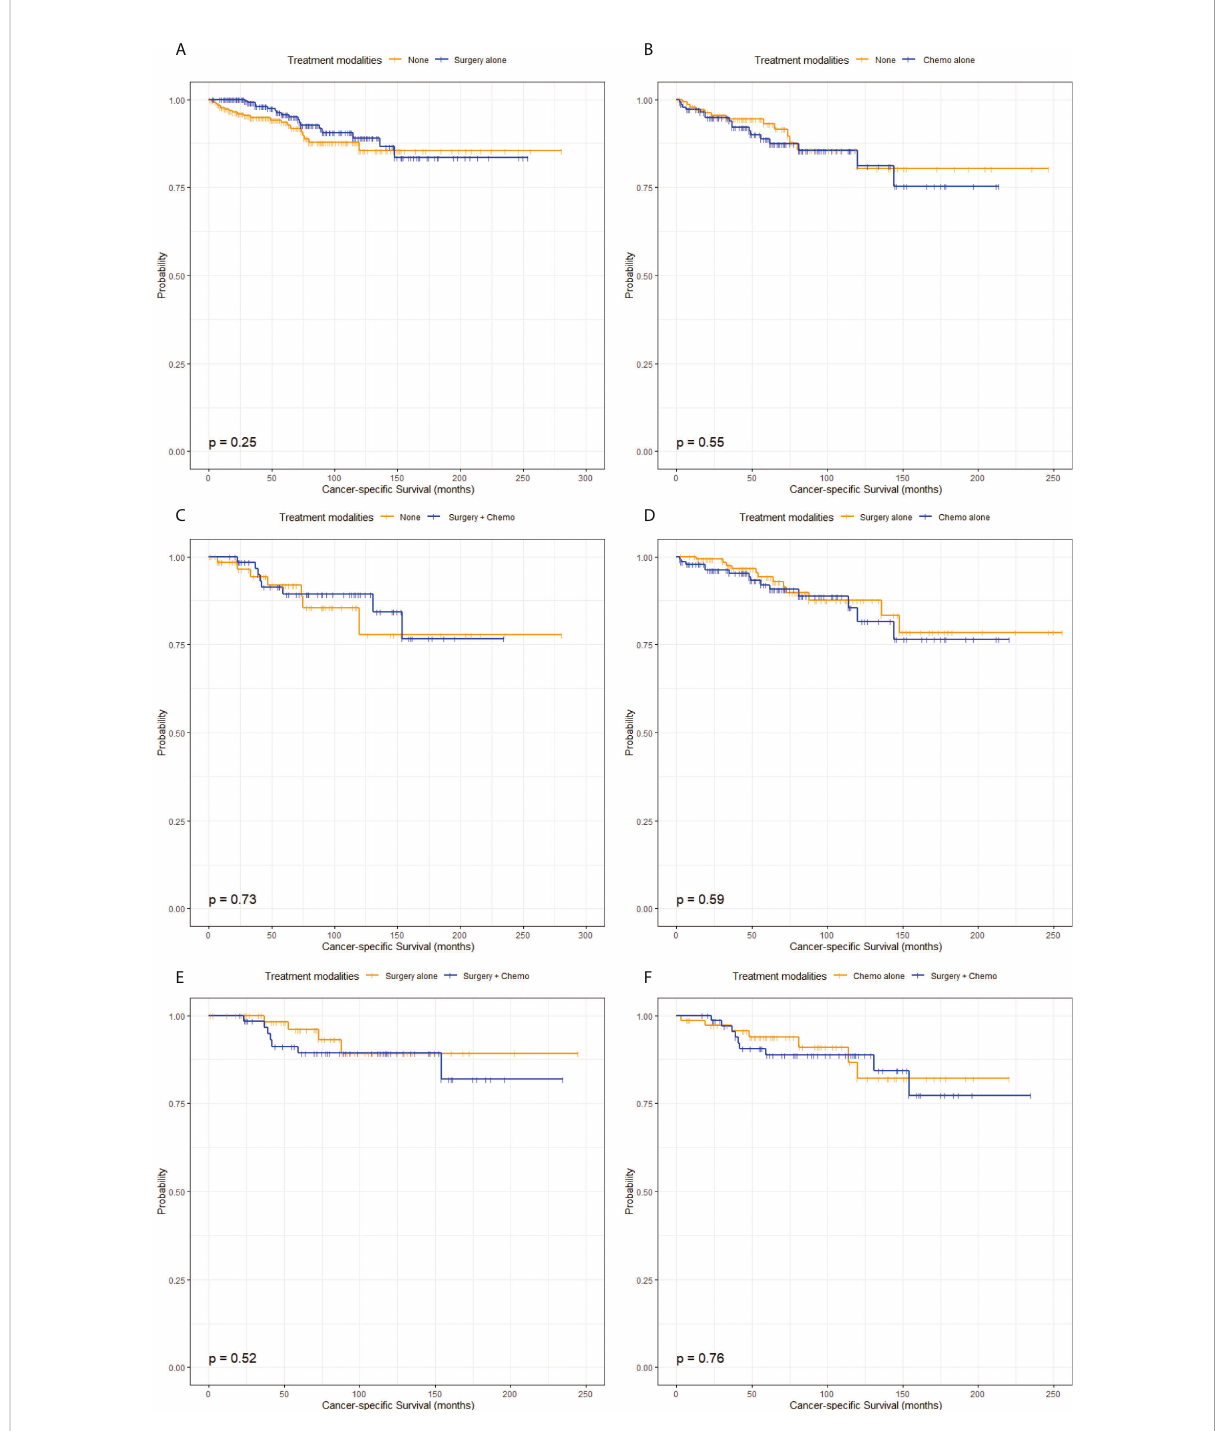
FIGURE 4 Kaplan-Meier survival curves of cancer-speci fi c survival strati fi ed by treatment modalities after propensity score-matching. (A) Kaplan-Meier survival curve of cancer-speci fi c survival between the None group and the Surgery alone group. (B) Kaplan-Meier survival curve of cancer- speci fi c survival between the None group and the Chemo alone group. (C) Kaplan-Meier survival curve of cancer-speci fi c survival between the None group and the Surgery + Chemo group. (D) Kaplan-Meier survival curve of cancer-speci fi c survival between the Surgery alone group and the Chemo alone group. (E) Kaplan-Meier survival curve of cancer-speci fi c survival between the Surgery alone group and the Surgery + Chemo group. (F) Kaplan-Meier survival curve of cancer-speci fi c survival between the Chemo alone group and the Surgery + Chemo